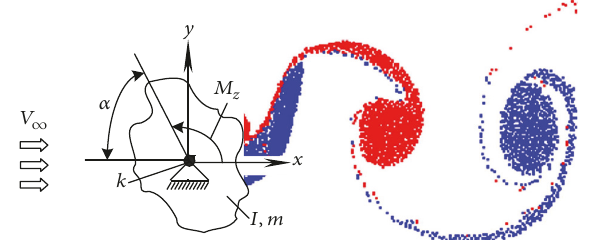
Figure 1: The airfoil of irregular shape with one rotational degree of freedom and schematic view of vortex wake behind it.